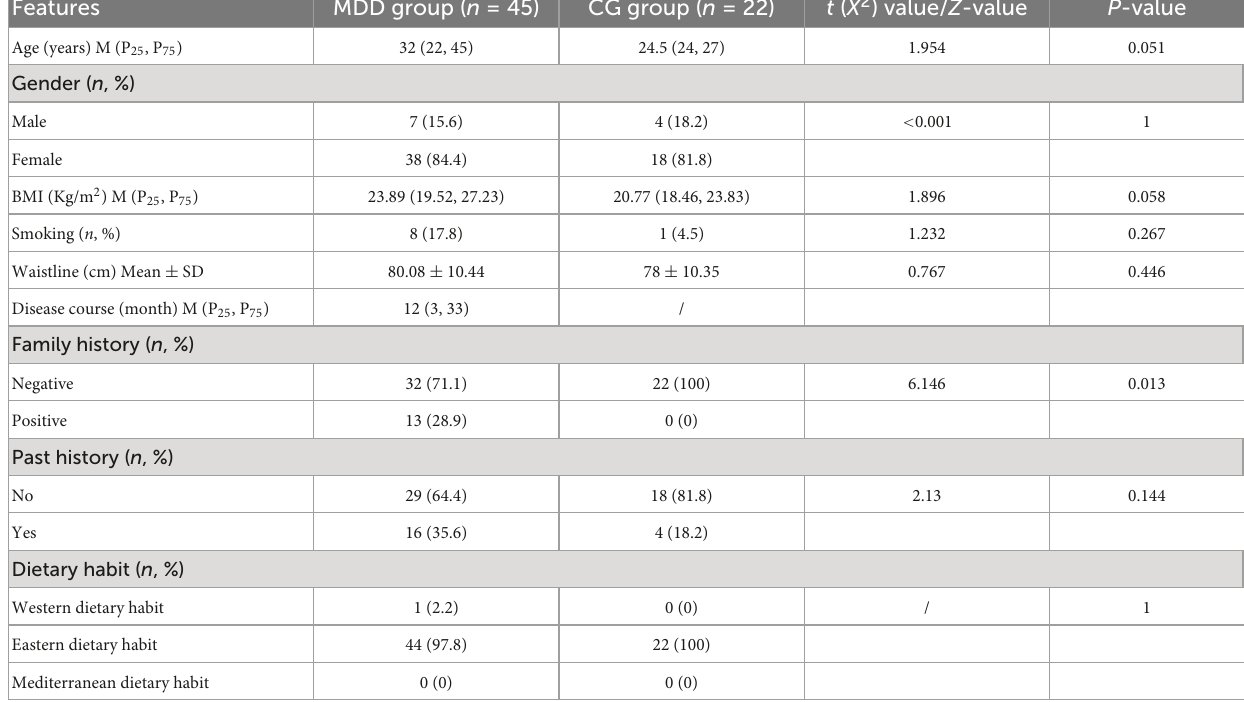
TABLE 1 Comparison of demographics between the MDD group and the CG group.